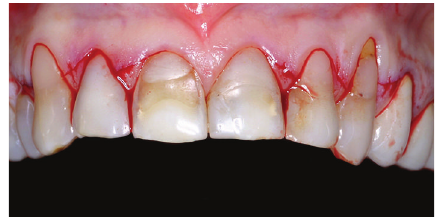
Figure 3: Flap incision.